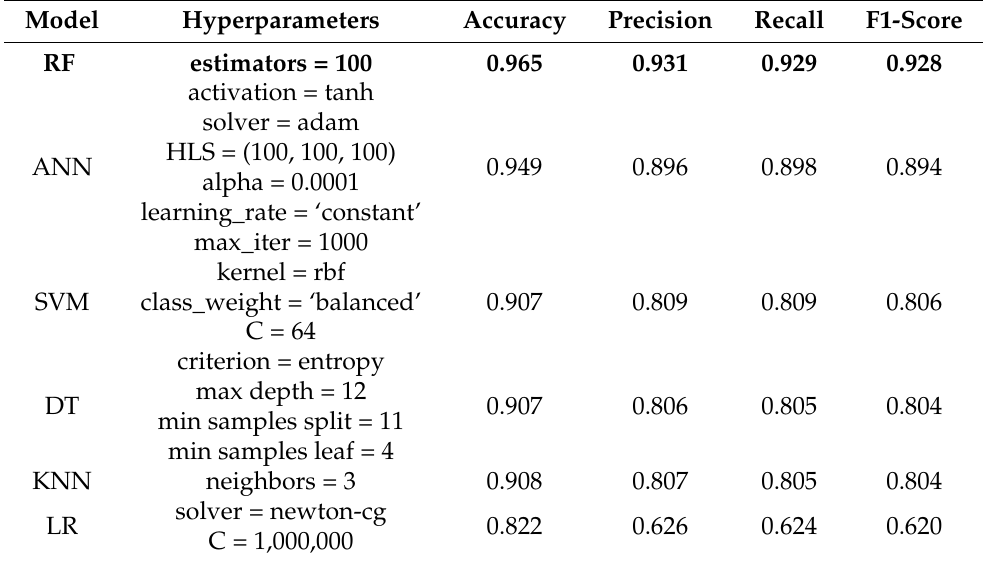
Table 6. Mean performance of the classification methods for fatigue detection in walking task. Bold values show the best score for each performance